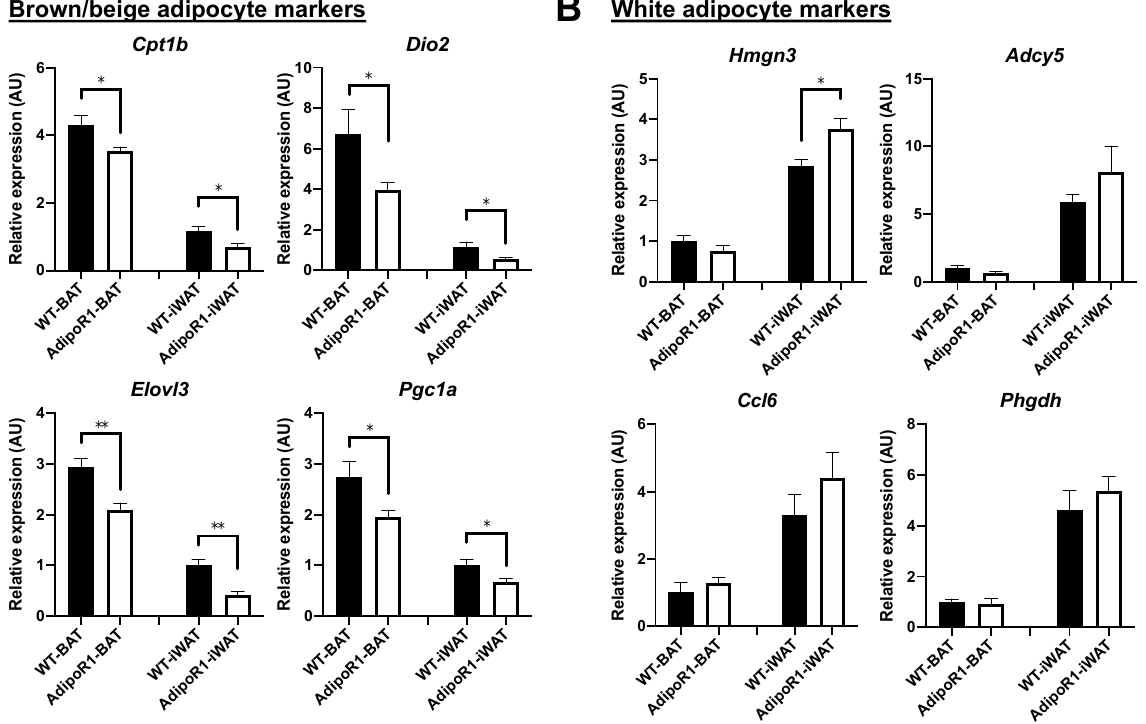
Figure 9. Reduced BAT markers (browning/beiging) and enhanced WAT markers (whitening) in classical brown and beige adipose depots of AdipoR1 mice after cold-stimulation. Expression of ( A ) brown and ( B ) white adipocyte markers was evaluated in indicated adipose tissues of WT and AdipoR1 female mice following cold exposure. Timeline and procedures were described in Figure 1. Classical iBAT and iWAT (the potential white adipose depot for browning or beiging), in WT and AdipoR1 female mice, were harvested, extracted, and measured to evaluate selective markers for brown or white adipocytes ( n = 3–8 for each group). Data were presented as relative means (normalized to β -actin in arbitrary units, AU) ± SEM. * p ≤ 0.05; ** p ≤ 0.01.